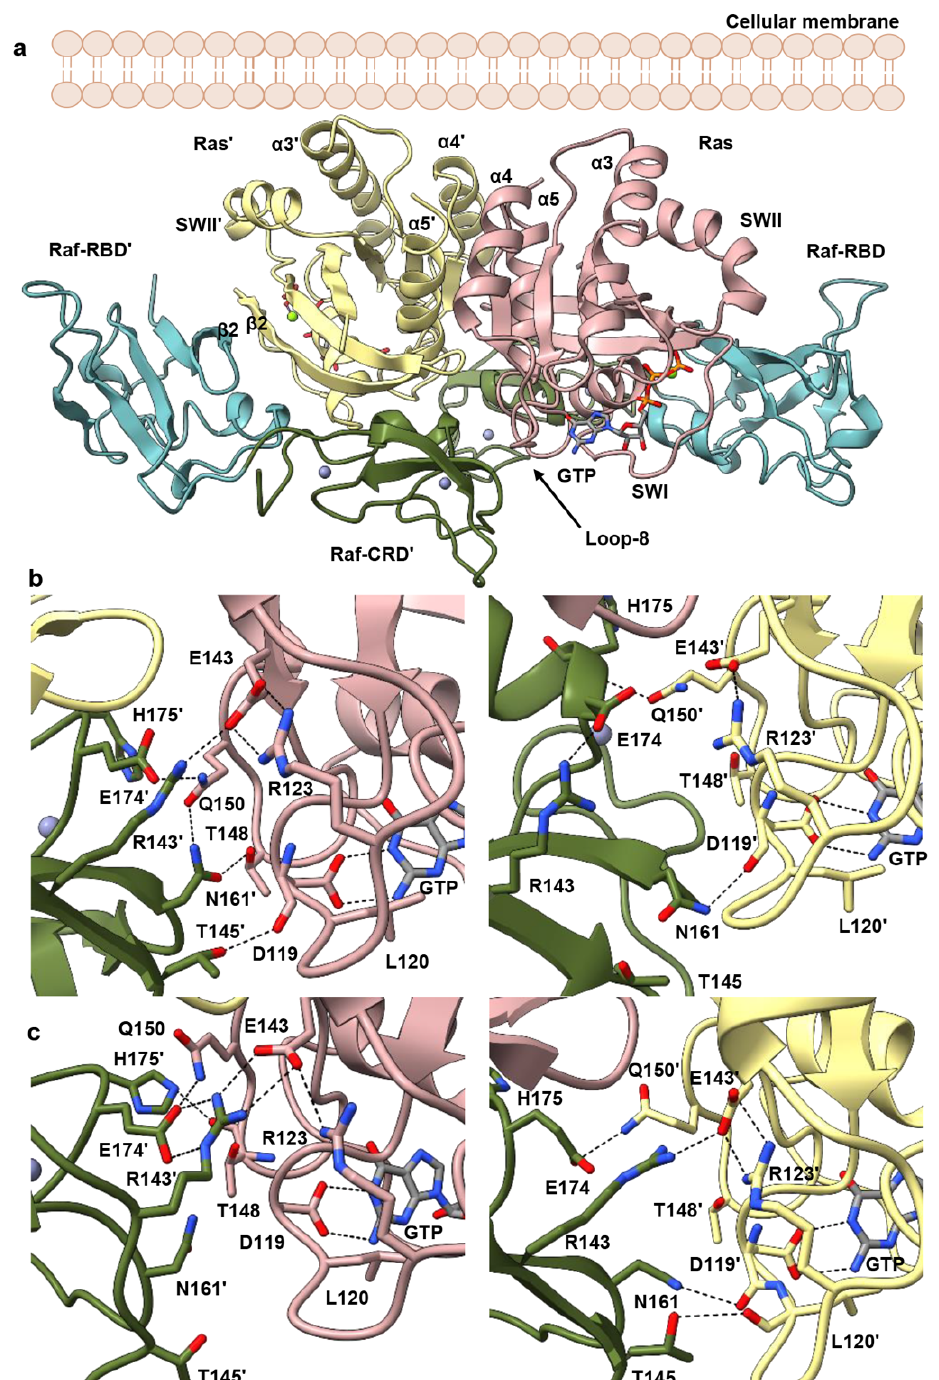
Figure 2. HRas–CRaf-RBD_CRD dimer complex. ( a ) Modelled HRas–CRaf-RBD_CRD dimer complex. Approximately perpendicular orientation of helices 3, 4 and 5 with respect to the membrane does not allow the Raf-CRD to interact with the membrane. ( b ) Frame taken from the replicate 2 HRas–CRaf-RBD_CRD simulation after 60 ns shows sample Ras–Raf-CRD’ ( left ) and Ras’/Raf-CRD (right) interactions. ( c ) Frame taken from replicate 3 HRas–CRaf-RBD_CRD simulation after 140 ns shows sample Ras–Raf-CRD’ ( left ) and Ras’/Raf-CRD ( right ) interactions. Right and left panels in b and c illustrate the asymmetry introduced through the Raf-CRDs’ dynamic interaction with the opposing Ras protomers. One protomer of HRas in the dimer is shown in pink and the other, HRas’ in yellow. Both CRDs in the dimer, CRD and CRD’ are shown in dark green.